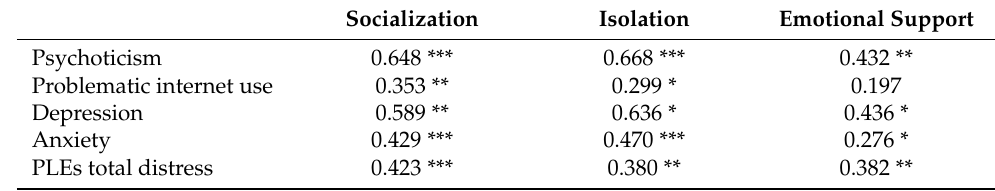
Table 2. Latent correlations between the three HQ-25 factors and psychological constructs.